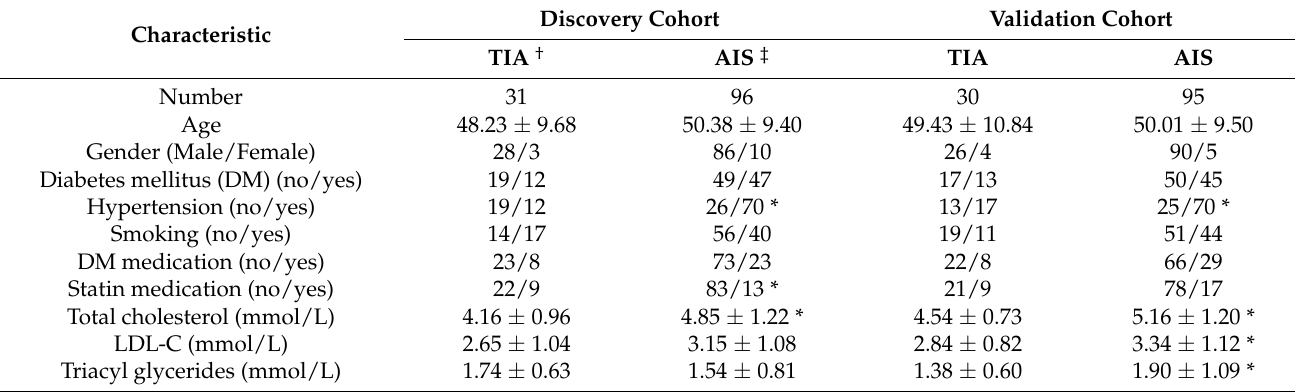
Figure 1. Study design and analysis workflow. ( A ). Serum samples were collected from acute ischemic stroke (AIS) and transient ischemic attack (TIA) patients within 24 h of clinical diagnosis, to purify circulating microRNAs (miRNAs) for transcriptomic analysis by RNA-Seq. Stringent analyses criteria enabled identification of differentially regulated circulating miRNAs in AIS patients compared to TIA patients. Downstream analyses for the gene targets of identified miRNA panel were performed to highlight the molecular pathways and networks affected in AIS. ( B ). The study population comprised TIA ( n = 61) and AIS ( n = 191) patients who were randomly divided into discovery and validation cohorts for identification of replicated, differentially regulated circulating miRNAs in AIS patients compared to TIA patients. Table 1. Characteristic features of the study cohort.